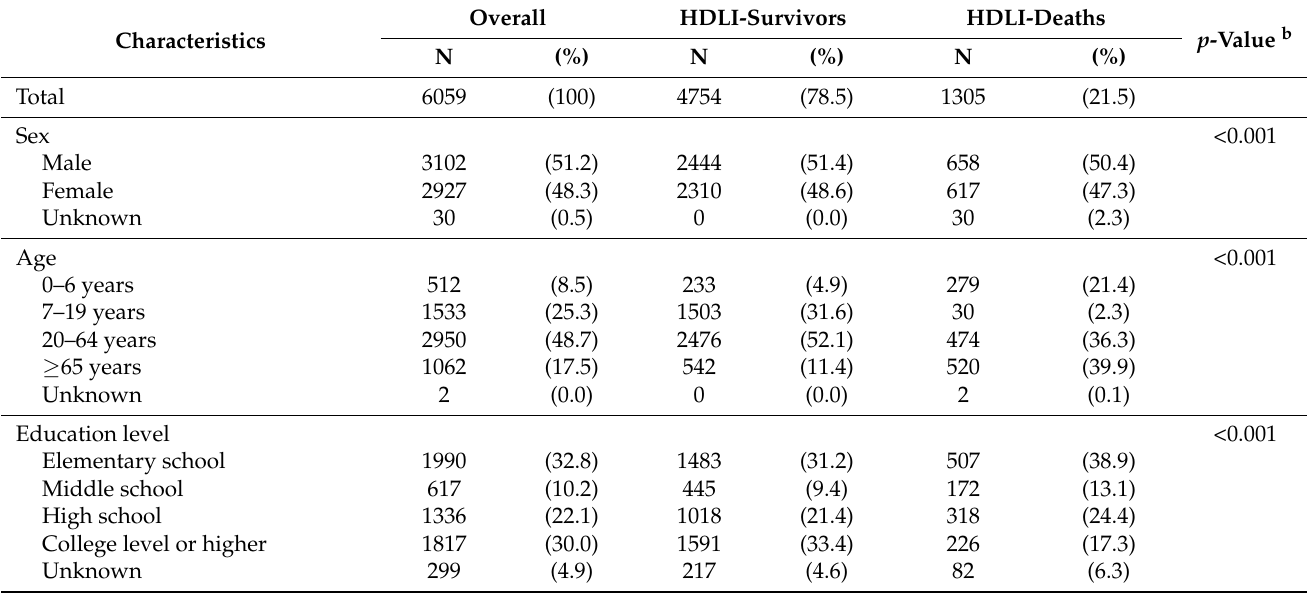
Table 4. Participants’ characteristics of self-reported HDLI cases by survival status ( n = 6059) a